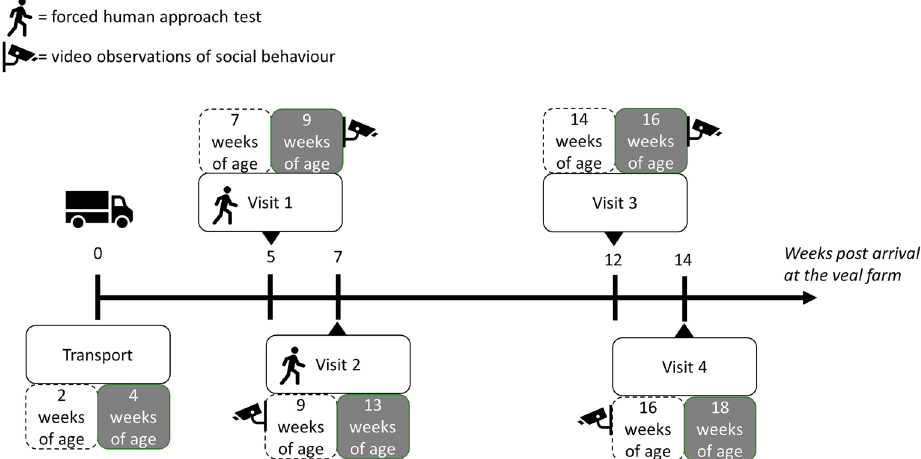
Figure 2. Schematic explanation of timing for forced human approach test, performed at 5 and 7 weeks after arrival at the veal farm, regardless of transport age, and video observations performed at 9 and 16 weeks of age, hence corrected for transport age. The dashed boxes represent the calves that were transported at 2 weeks of age, while the grey boxes represent the calves transported at 4 weeks of